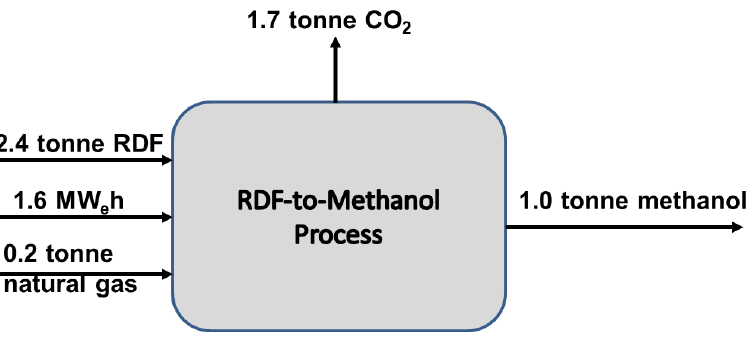
Figure 4. Key process inputs and outputs for a basis of one tonne methanol.